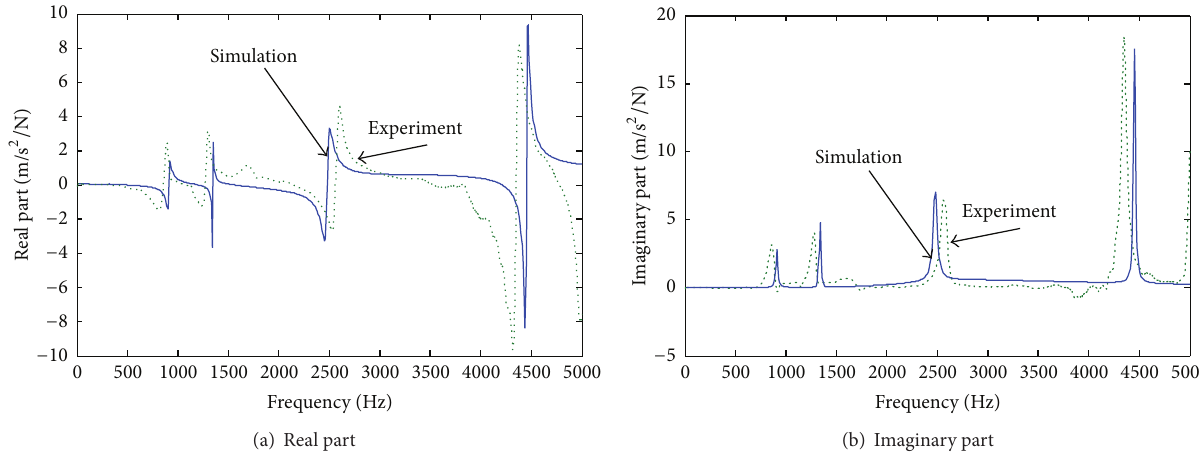
Figure 11: Experimentation versus simulation of H 𝑦𝑦 at front tip.